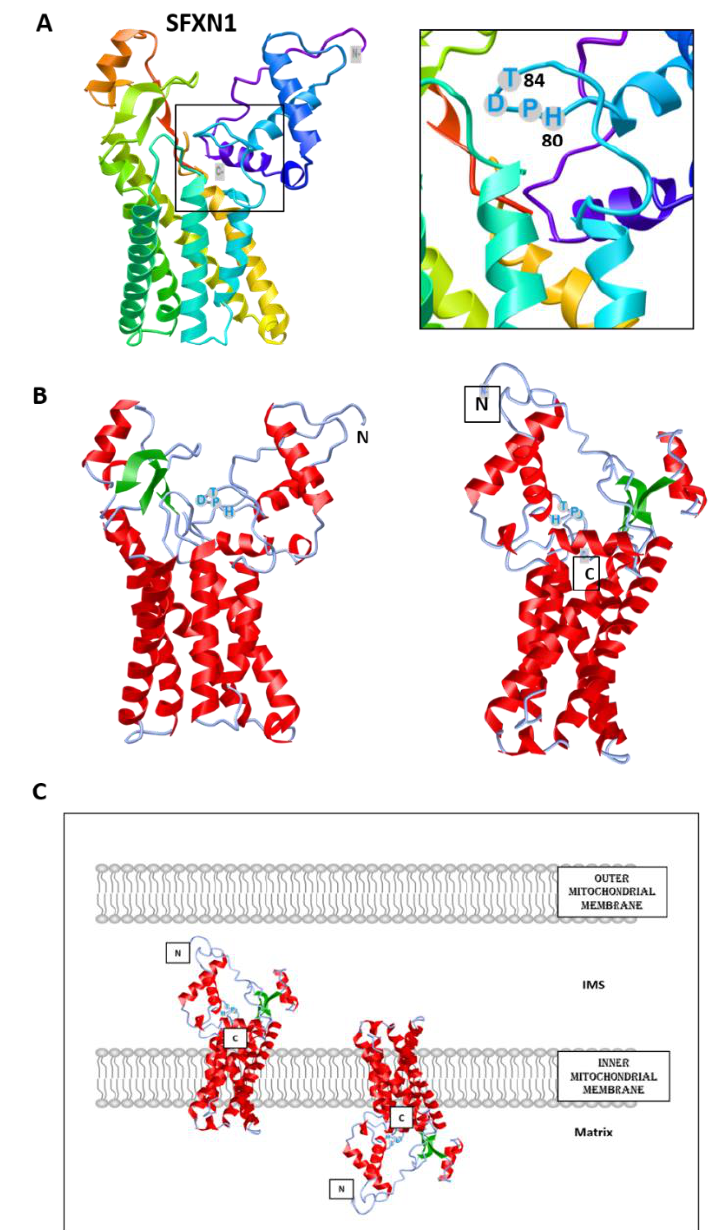
Figure 2. Predicted structure of human SFXN1. Structure prediction was obtained using trRosetta. The confidence of the predicted model shown here is very high (with estimated TM-score = 0.806). The model was built by trRosetta based on de novo folding, guided by deep learning restraints. iCn3D was used for the visualization of 3D structure [13]. ( A ). SFXN1 predicted structure reveals several alpha helices and beta strands. N and C termini are labelled. The inlet shows the position of the HPDT motif (aa 80–83), located just after the fourth helix. ( B ). Two views highlighting secondary structures (helices in red, beta sheets in green). ( C ). Models for SFXN1 insertion in the inner mitochondrial membrane.